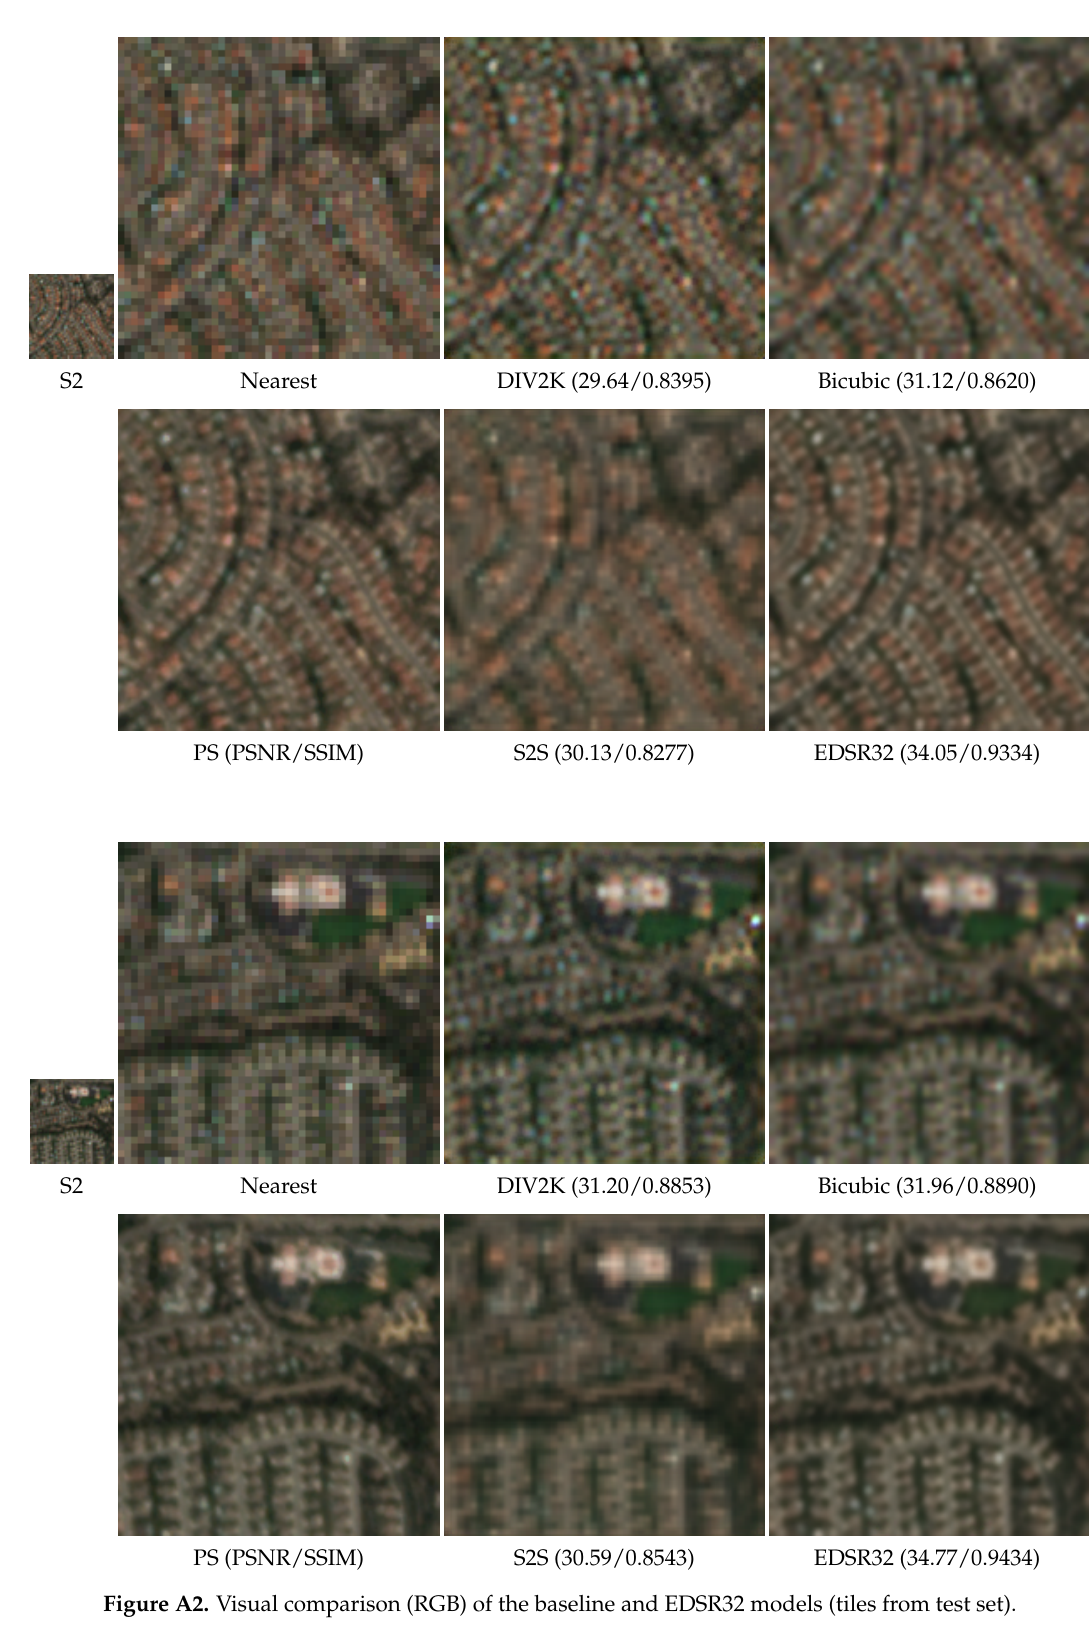
Figure A2. Visual comparison (RGB) of the baseline and EDSR32 models (tiles from test